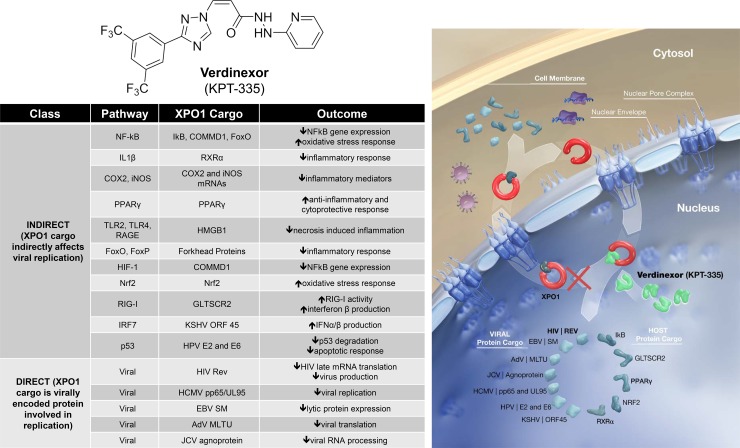
Chemical structure, mechanism of action, and important molecules with XPO-1-relatedness.Top Left: Chemical Structure of verdinexor. Bottom Left: Molecules that rely on XPO1 for nuclear export are highlighted, including those that have either direct or indirect effects on viral replication and inflammation. This list is not exhaustive but represents cargoes that are important for viral life cycles. Right: Diagram of the mechanism of action of verdinexor at the cytosolic/nuclear interface.